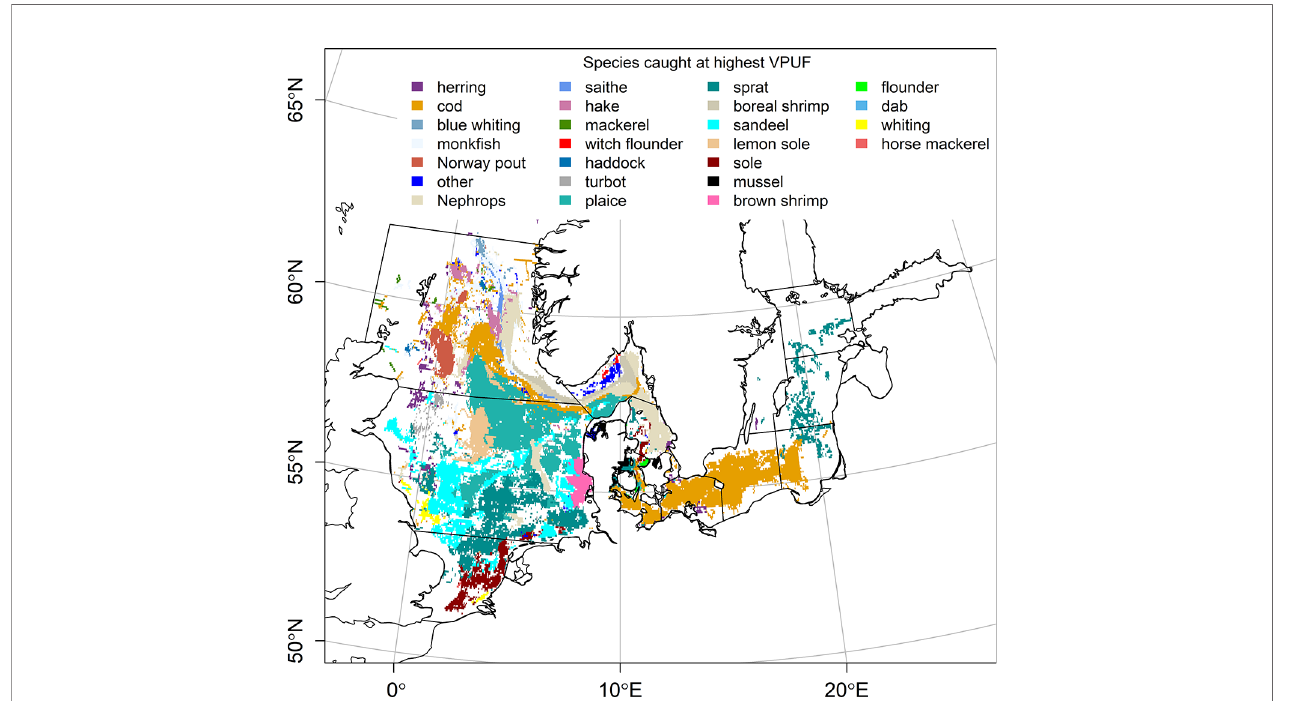
FIGURE 3 | Map showing, for all grounds fi shed by Danish demersal fi shing vessels >12m in length, the species caught at highest value (EUR) per unit fuel (VPUF) during 2005-2019 (in FAO 22.3 Baltic Sea, FAO 22.4 North Sea and part of FAO 22.2 in North-East Atlantic) aggregated on 1x1 minute grid cells.